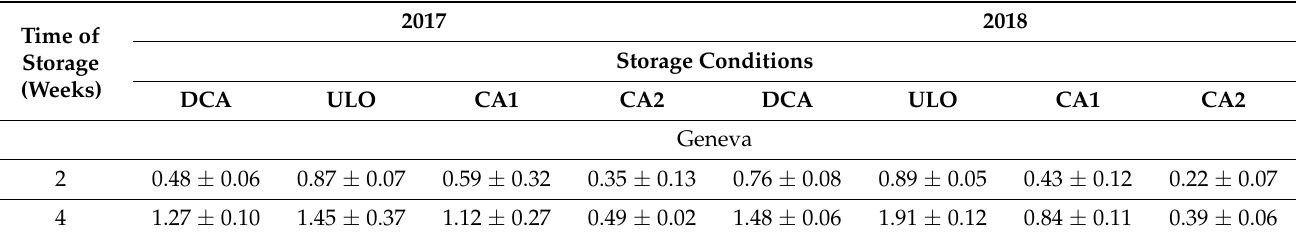
Table 9. Changes in fruit mass loss (%) measured in ‘Geneva’ and ‘Ananasnaya’ minikiwi fruits in the postharvest period. Time of Storage